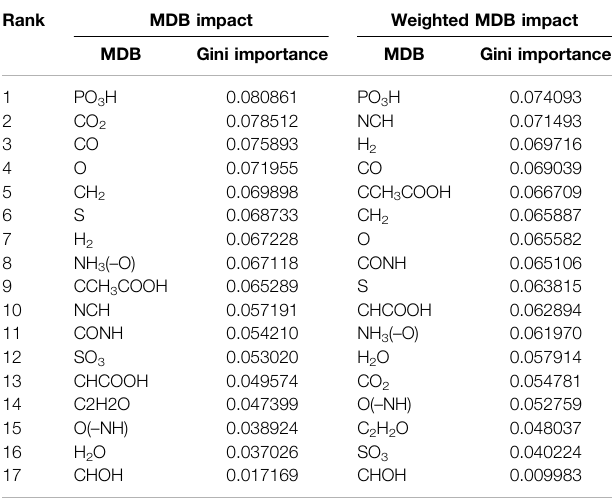
TABLE 4 | MDB gini importance for the RF model developed from the MDBI and WMDBI values for the YD